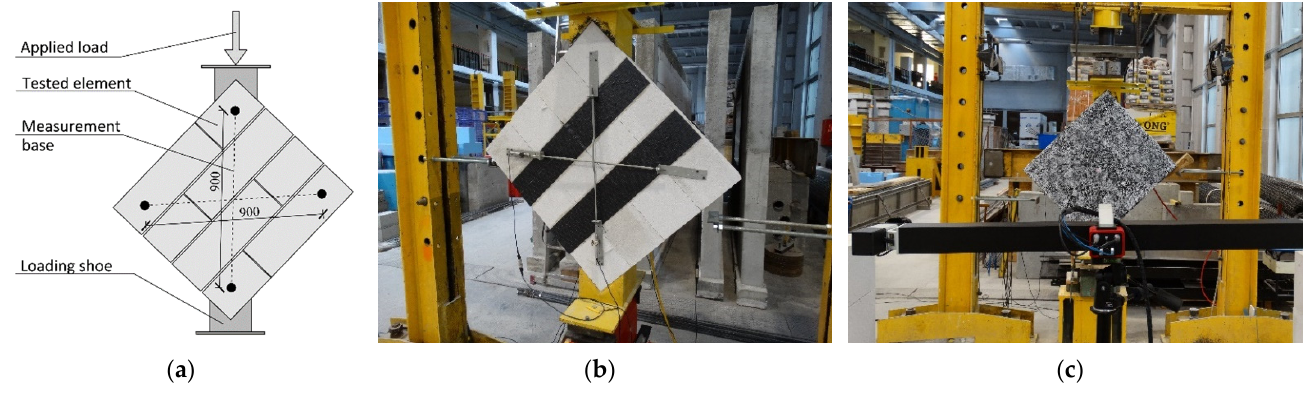
Figure 3. Masonry wallets prepared for tests: ( a ) test setup; ( b ) model with traditional measurement system; ( c ) model with surface prepared for optical measurements.